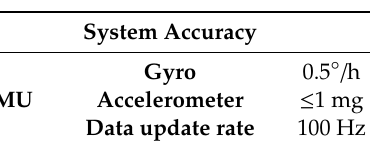
Table 5. System accuracy of Crossbow VG700AB.